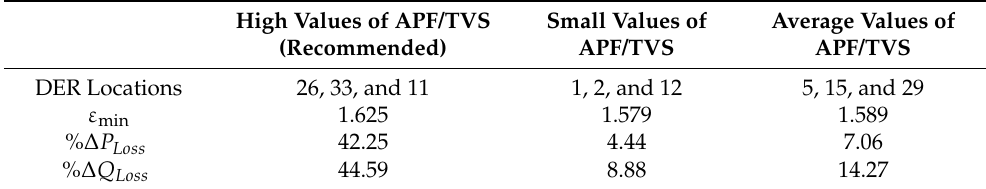
Table 2. Results comparison in terms of the system smallest eigenvalue, and network losses reduc- tion percentage.